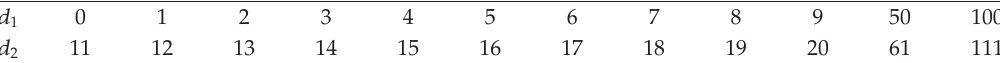
Figure 2: Global convergence of states x 1 and x 2 in Example 5.2, when d 1 (cid:8) 1 and d 2 (cid:8) 3. Table 1: Allowable upper bound of d 2 with given d 1